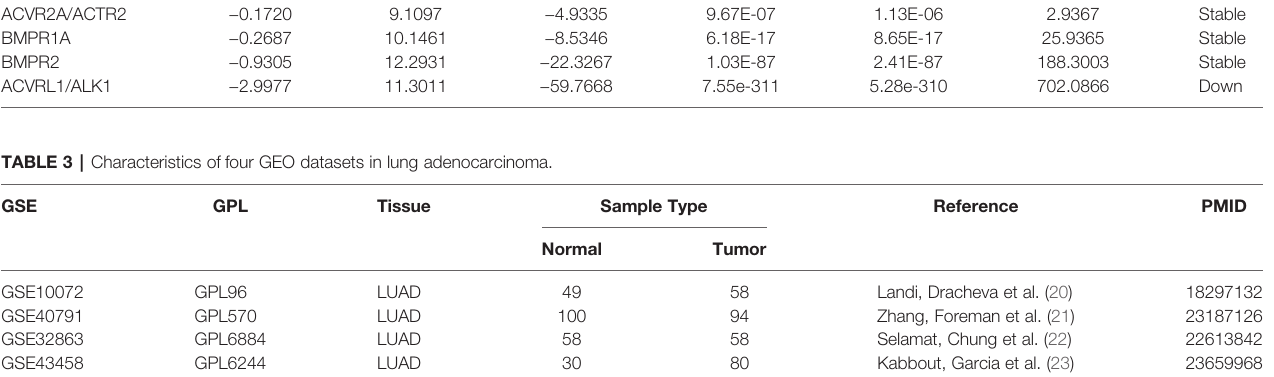
LUAD, lung adenocarcinoma.